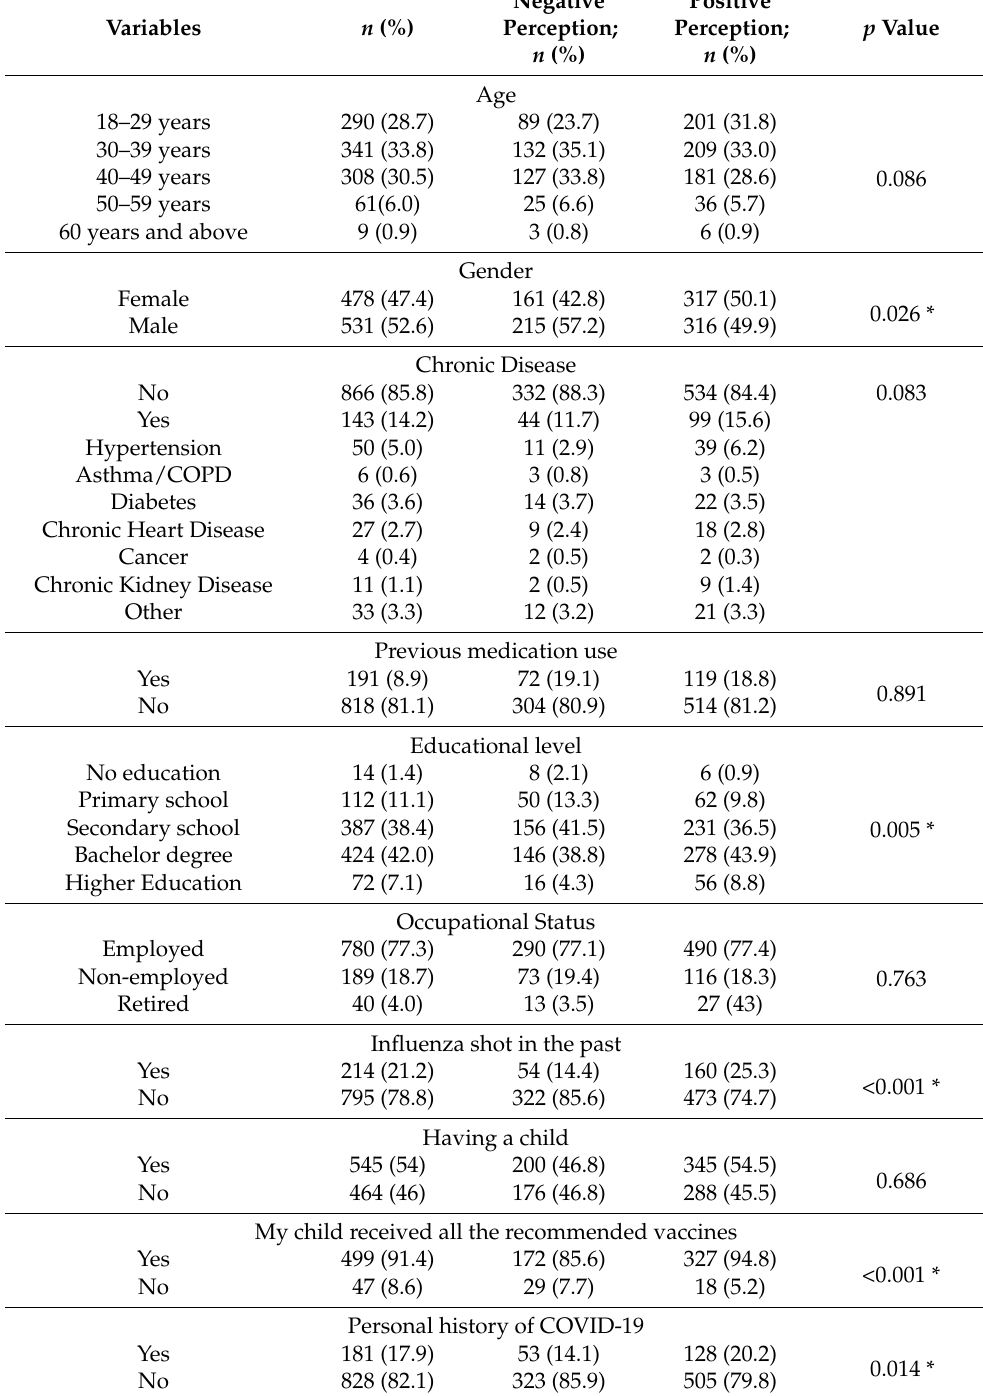
Table 2. Baseline characteristics and comparison of adequate perceptions ( n = 1009), * p <